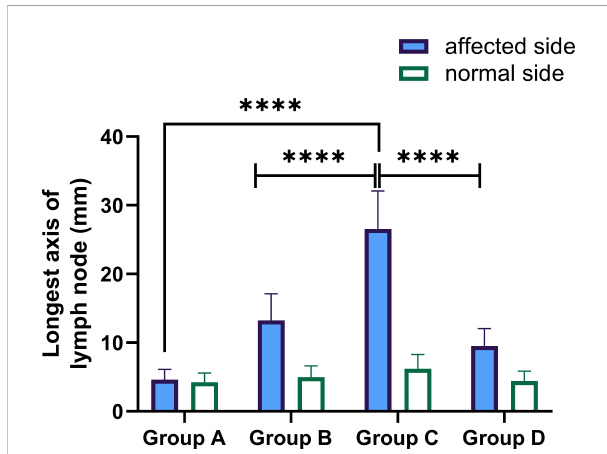
FIGURE 3 Performance of longest axis of the inguinal lymph node in the affected and normal lower limbs in each group. Group (A) = primary arthroplasty, Group (B) = aseptic revision, Group (C) = fi rst stage of a 2-stage exchange revision protocol, Group (D) = second stage of a 2-stage exchange protocol (reimplantation), **** p-value< 0.0001.